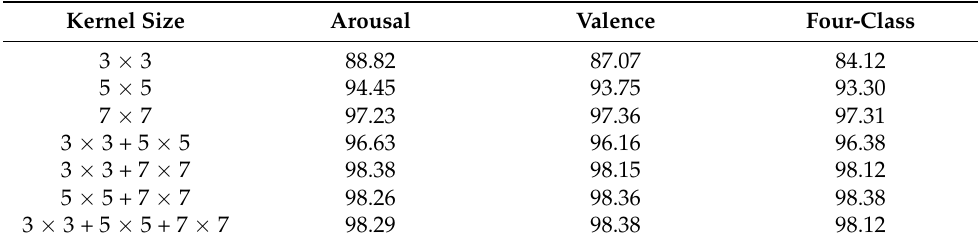
Table 3. Classification accuracies of the proposed network on different kernel